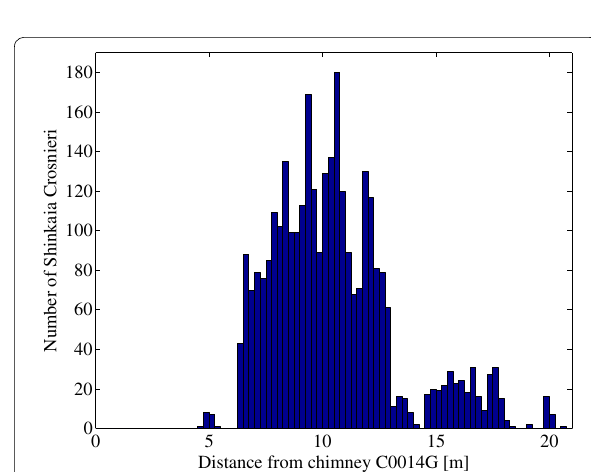
Fig. 7 Histogram showing the relationship between the number of S. crosnieri and the radial distance from the chimney mouth of chimney